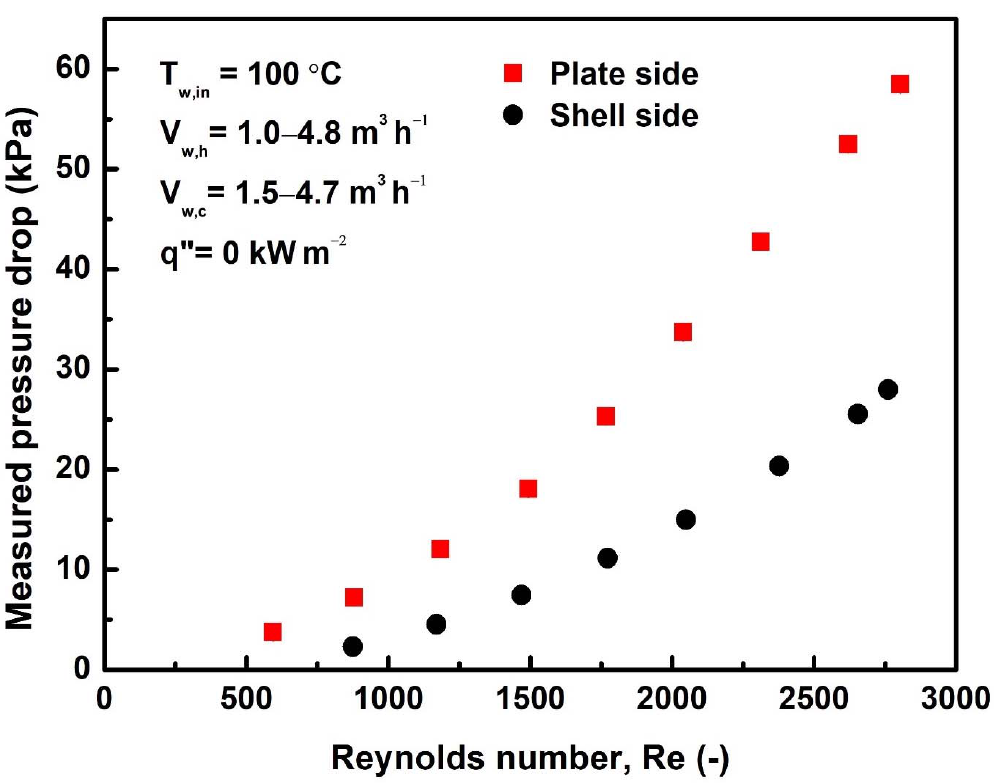
Figure 8. The pressure drop on plate and shell sides with respect to the Re in the PSHE. Figure 9 shows the variation in the pressure drop of water on the plate side concerning the Re and average temperature. As the temperature decreased, the pressure drop at a given Re increased due to the liquid viscosity and density increase. As the temperature was increased from 90 °C to 100 °C and from 100 °C to 110 °C, the water density was decreased by 0.72% and 0.77%, respectively.